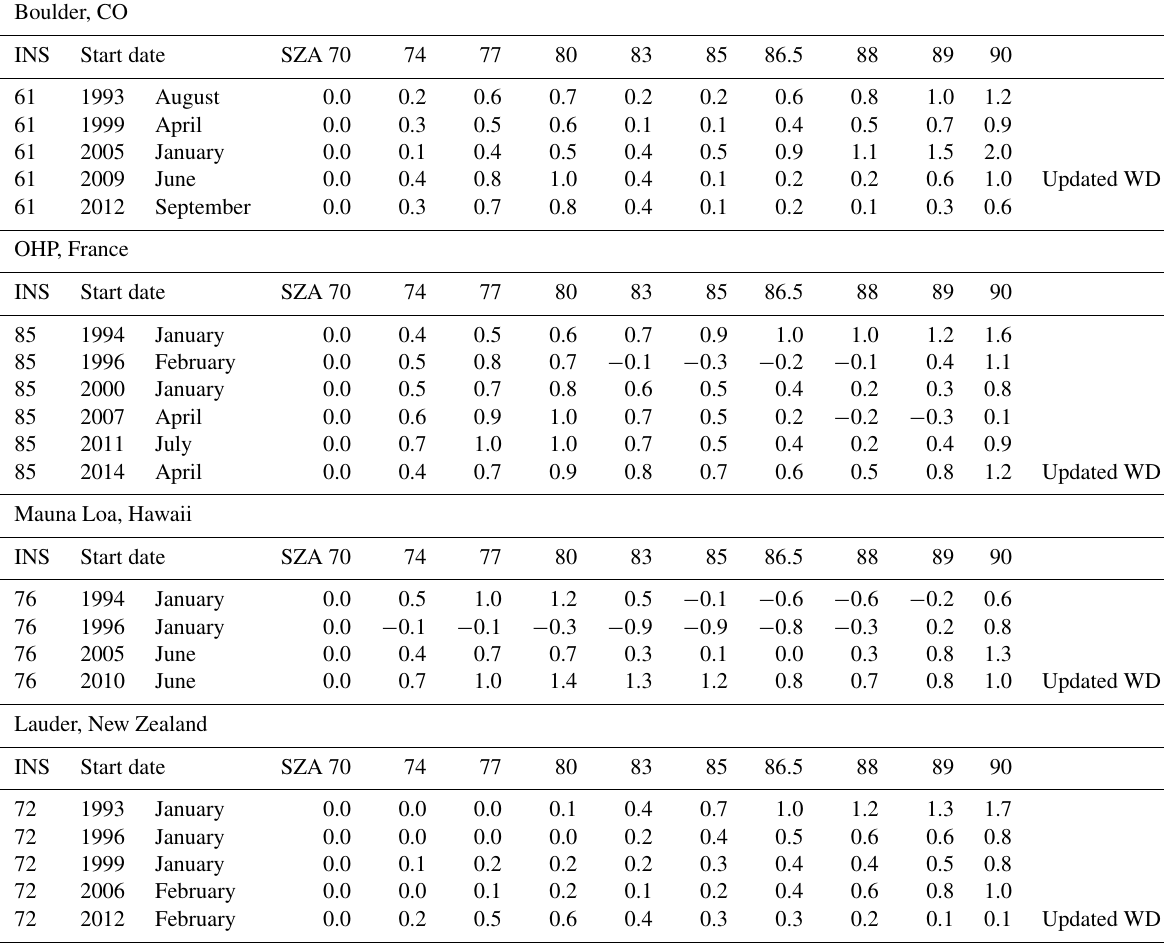
Table 2. Umkehr N -value-optimized corrections for each nominal solar zenith angle (70–90 ◦ SZAs) are shown for four Umkehr stations. All corrections are normalized to 70 ◦ SZA (set to zero at 70 ◦ SZA). The correction period is between the dates indicated in the second column. The last correction is through the end of 2020. The “updated WD” note on the right of the table identifies the WinDobson operating system installation date for Dobson